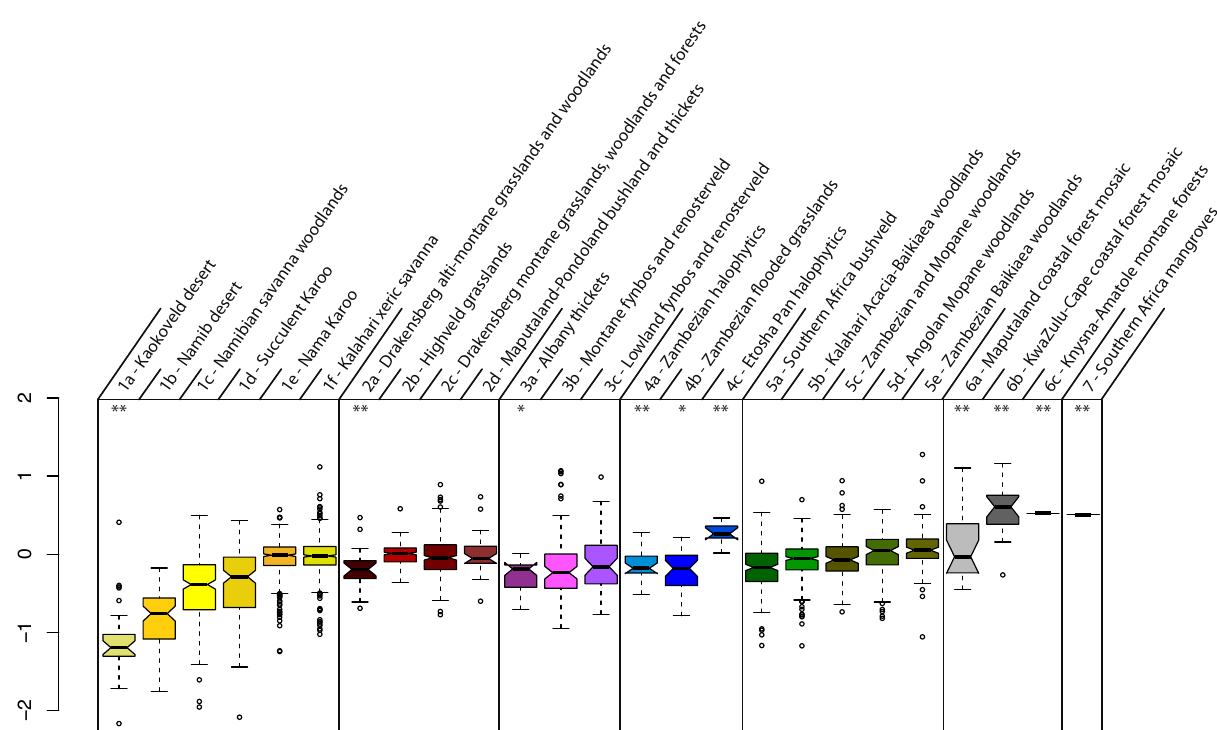
Figure 9. Box plots representing the dispersion of the normalized anomalies (Eq. 13) for each ecoregion. There is globally more dispersion within each ecoregion (length of the boxes) than between, confirming the results of the between-groups PCA (75% of variance not explained by the groups). ∗ means the ecoregion is composed of fewer than 50 grid cells; ∗∗ means fewer than 25. The numbers match those of Fig.